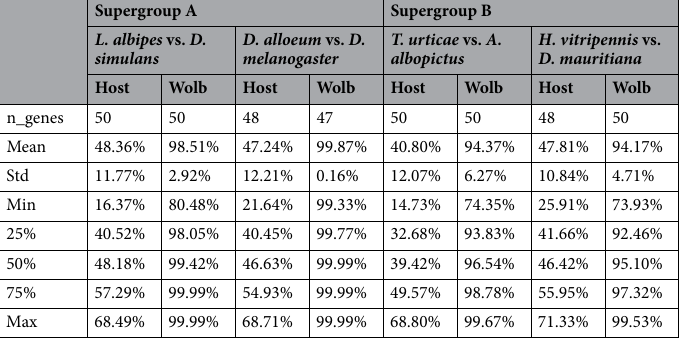
Figure 1. Heatmap showing: ( a ) Wolbachia similarity and ( b ) hosts similarity. Wolbachia heatmap shows the similarity from representatives of clades from supergroups A and B, also showing the Wolbachia phylogeny. Supergroup